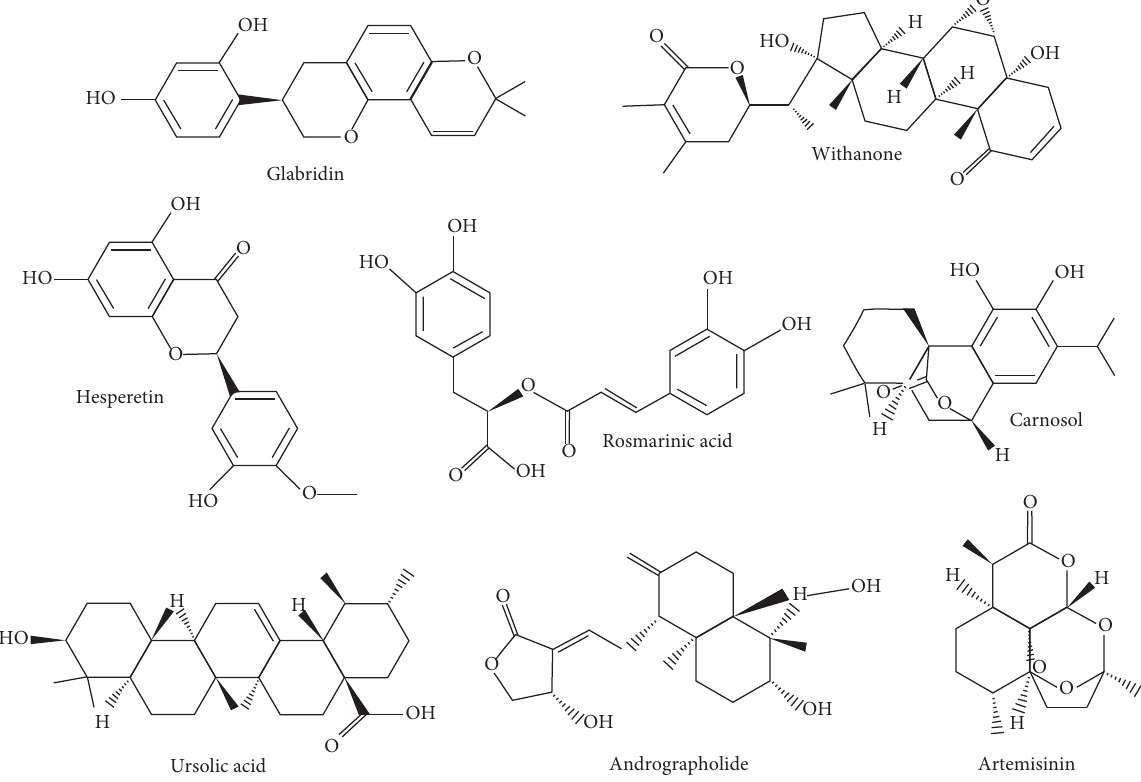
Figure 3: Potential plant-derived secondary metabolites having anti-SARS-CoV-2